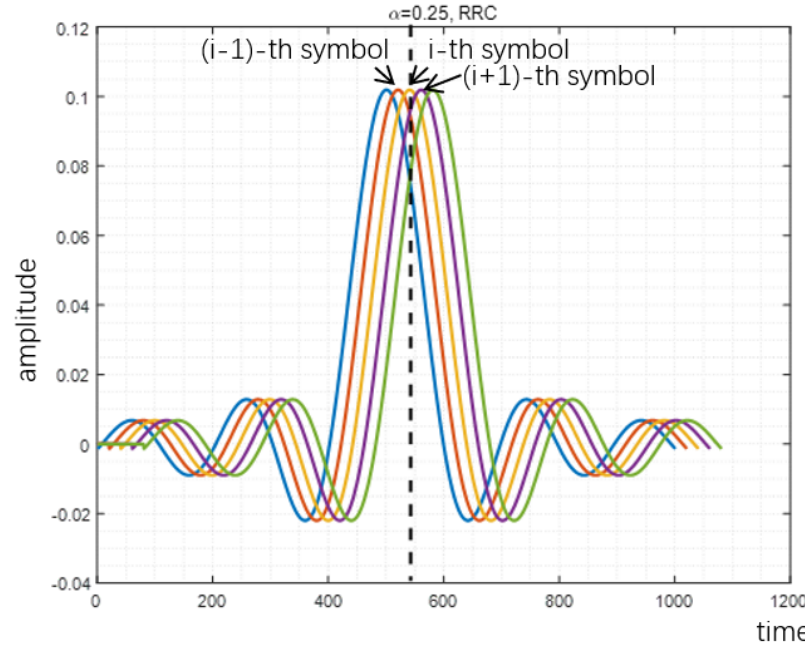
Figure 9. Peak value of RRC filter-based signal with α =